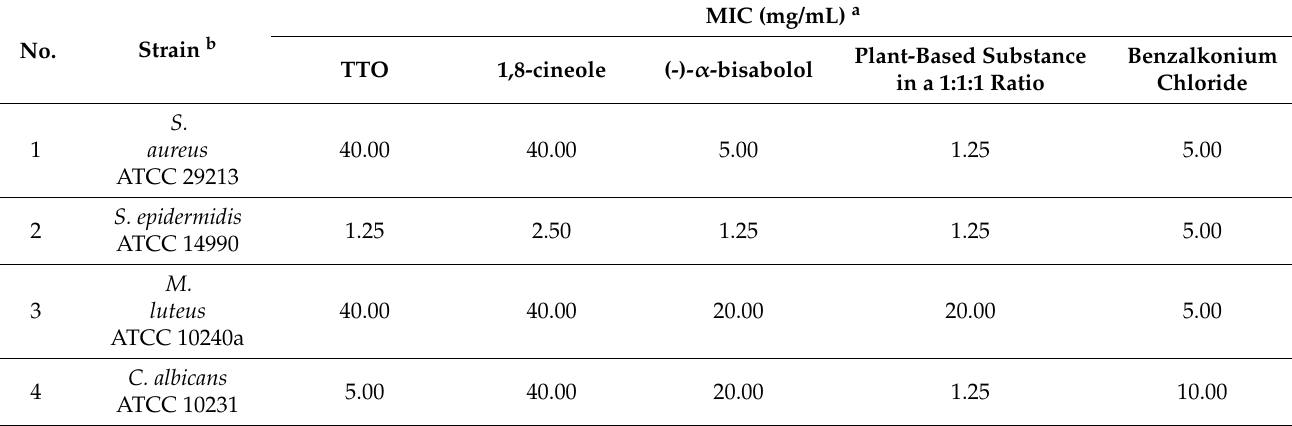
Table 4. MICs of the plant-based compounds and substances against reference microbial